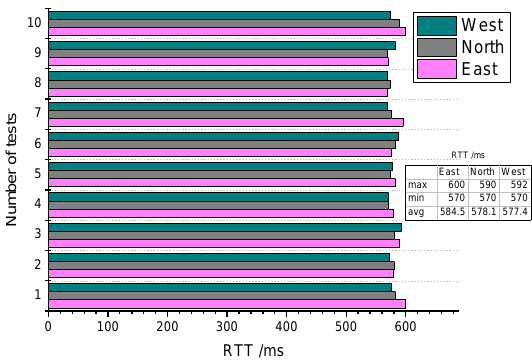
Figure 11. Relationship between RTT and position.